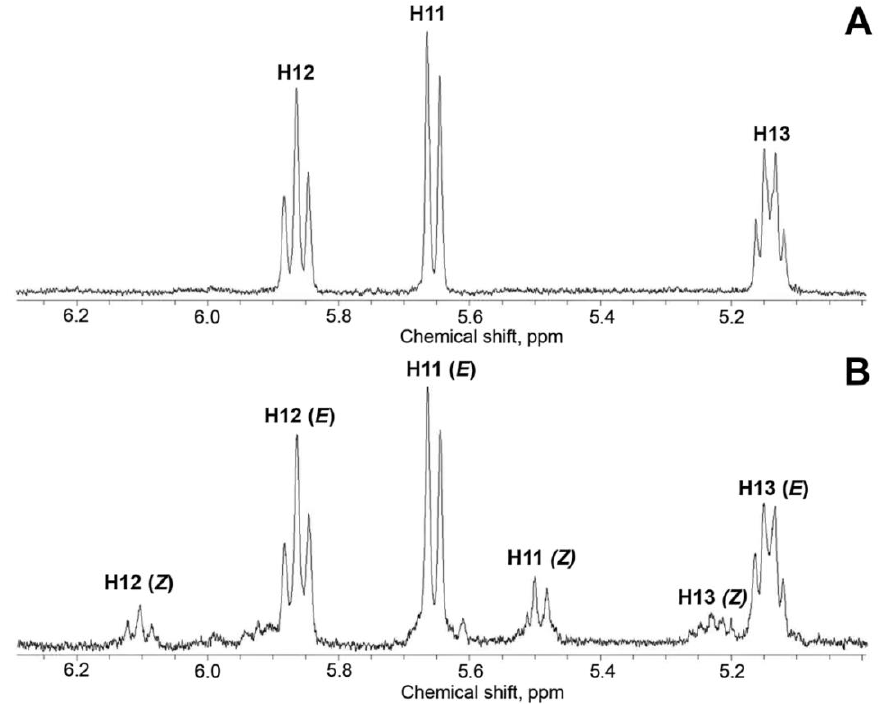
Figure 4. The partial 1 H-NMR spectra (600 MHz, [ 2 H 14 ]n-hexane, 253 K) of allene oxide (9,10-EOD) Me ester preparations obtained with ZmAOS ( A ) and LeAOS3 ( B ).